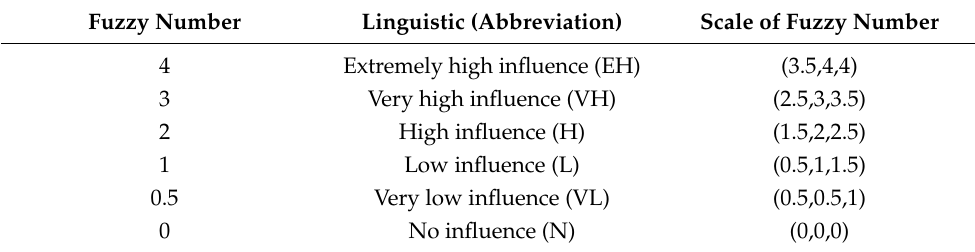
Table 4. Membership function of linguistic